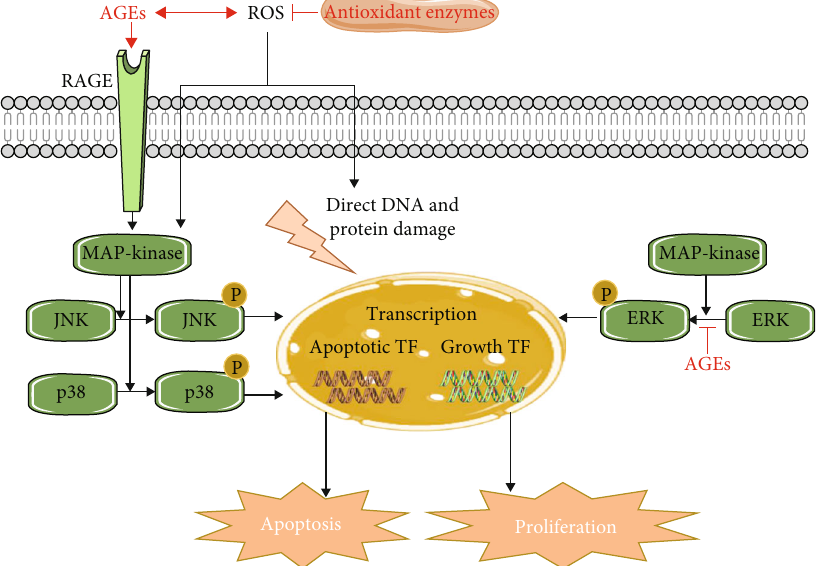
Figure 3: Interference of AGEs in the MAPK pathways. AGEs lead to an increase in apoptosis or a decrease in proliferation via the MAPK pathways. RAGE activation by AGEs causes activation of MAPK, which leads to phosphorylation of JNK and p38. These phosphorylated proteins increase the transcription of di ff erent proapoptotic transcription factors (TF), leading to an increase in apoptosis. Next to that, AGEs inhibit the phosphorylation of ERK, which normally promotes the transcription of growth factors leading to proliferation. Finally, AGEs also induce ROS formation by reducing the availability of antioxidant enzymes, which directly leads to DNA and protein damage. Indirectly, ROS interferes in the JNK/p38 MAPK